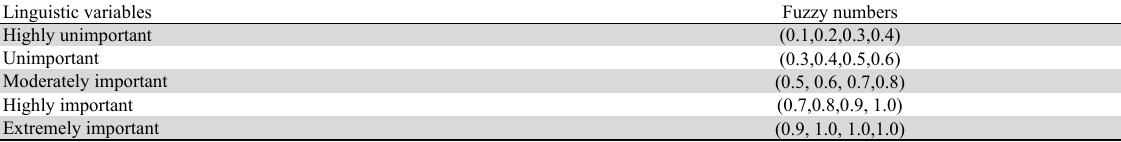
Linguistic terms and corresponding fuzzy numbers for each criterion Linguistic variables